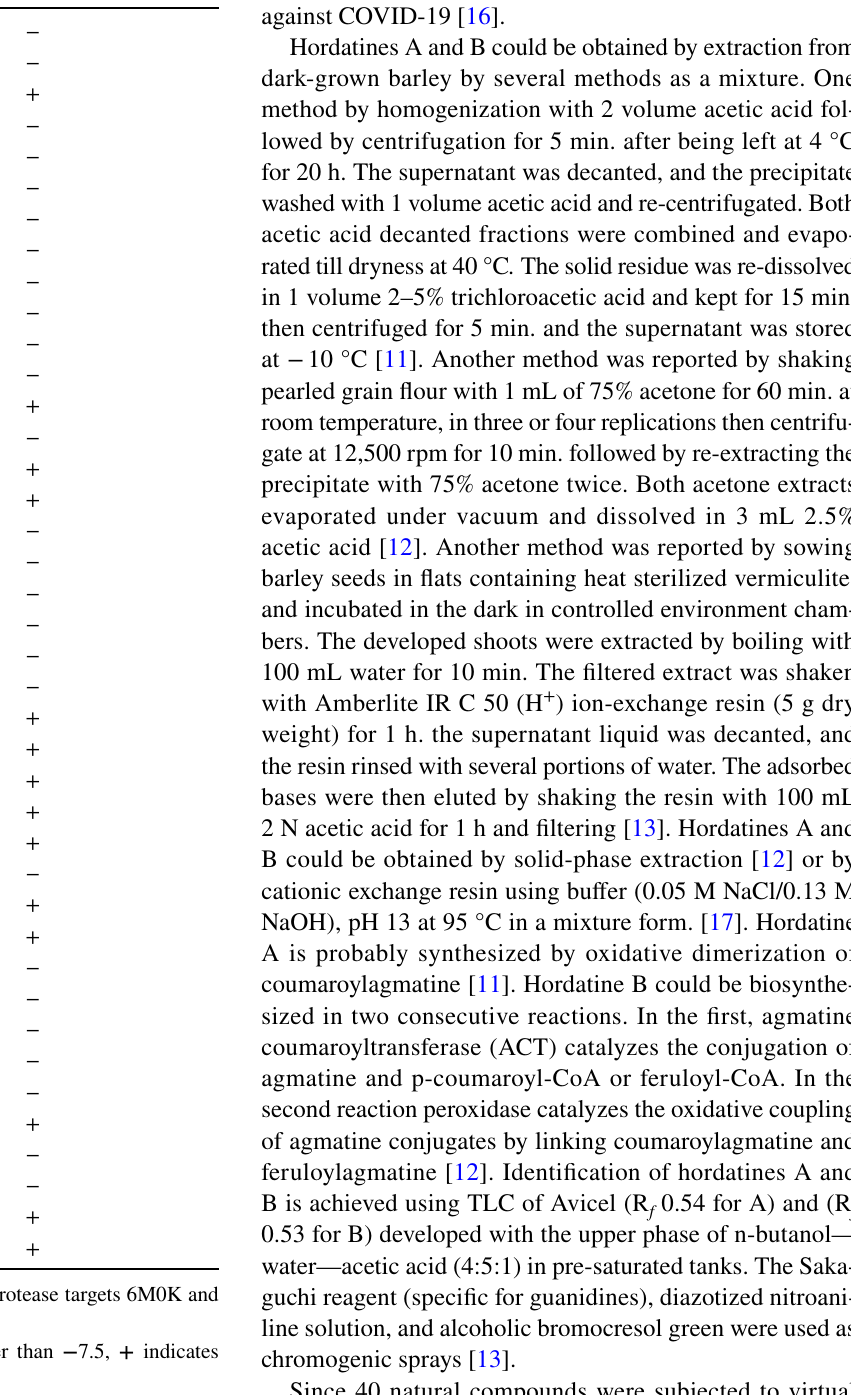
For Comparative docking study results on protease targets 6M0K and 6Y2F see Supplementary Data − Indicates that dock score value is higher than − 7.5, + indicates that dock score value is − 7.5 or